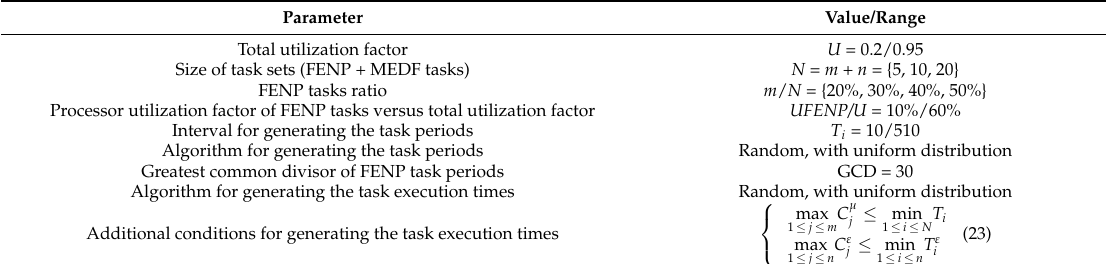
Table 1. Main setup parameters of the